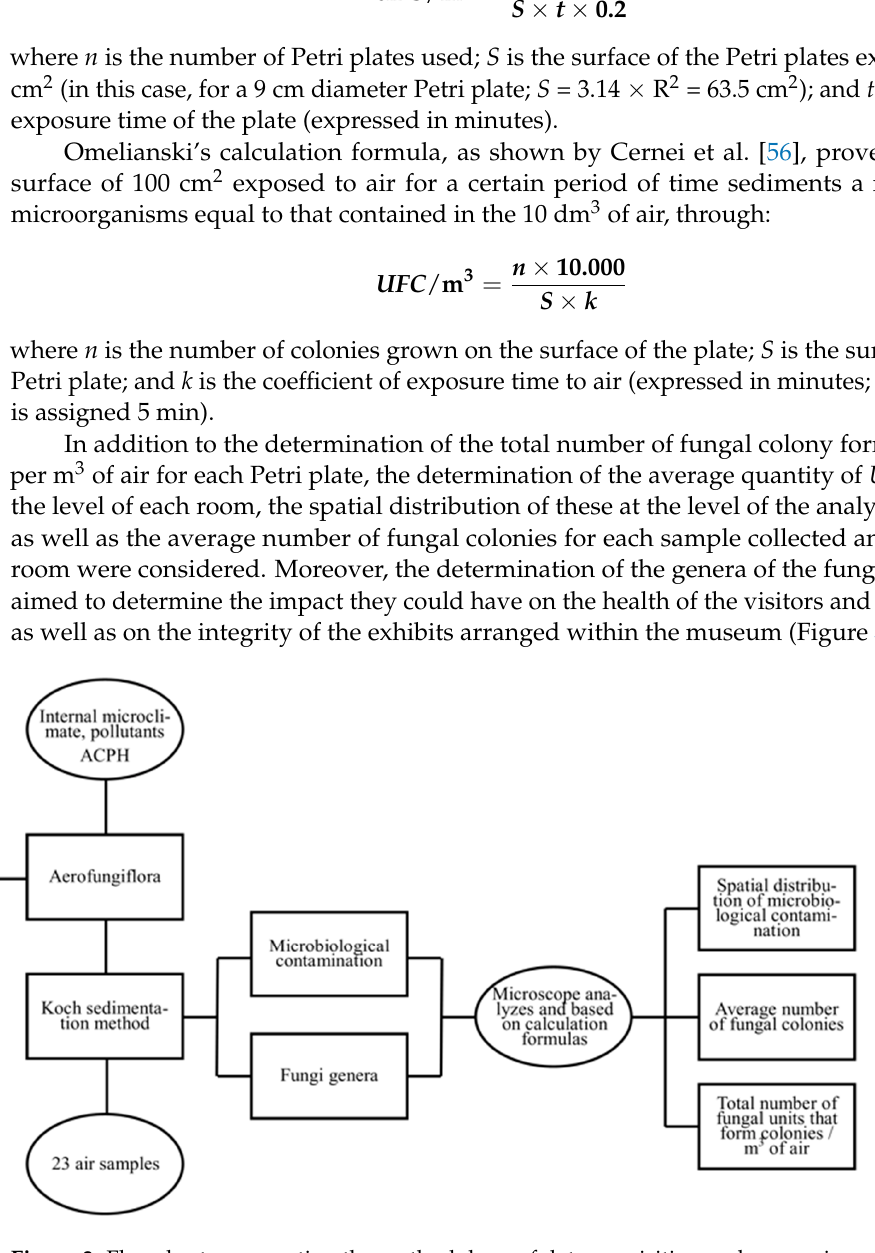
Figure 3. Flowchart representing the methodology of data acquisition and processing as well as the qualitative results obtained.